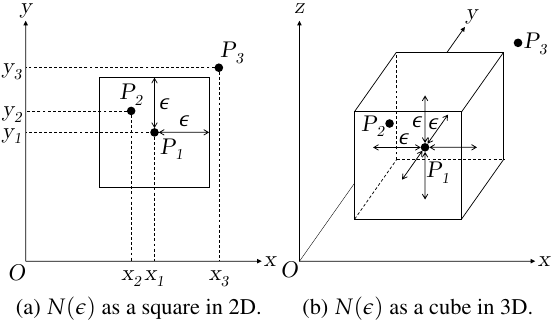
Figure 5. An illustration of the neighbourhood N ( (cid:101) ) of point P 1 in 2D (5a) and 3D (5b). P 1 is matched with P 2 .